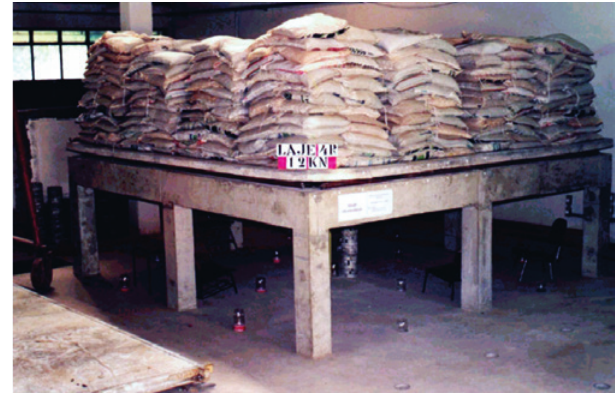
quadrant by positioning the devices on the central axis and in the diagonal of the slabs for symmetry purposes. Kiowa KLM PA 06 250BA 120L electric strain gages were also attached to the main flexural reinforcement, at 12 different points, of each slab. Two dia - metrically opposed strain gages per point were used in the lower and upper sides of the reinforcement in slabs L1 and L2. A single strain gage per point was used in the other slabs; it was fixed in the lower side of the reinforcement. Kiowa “KLM PA 06 201BA 120L” electrical strain gages were attached to four points on the concrete surface, and on the upper surface of all slabs, in order to measure the deformations. Figure 2 shows the position of the deflectom - eters and electrical strain gages fixed in the flexural reinforcement and on the concrete surface of the slabs. Slab L1 was loaded with 0.50 kN sandbags, whereas the other slabs were loaded with 0.25 kN bags. Each slab was initially